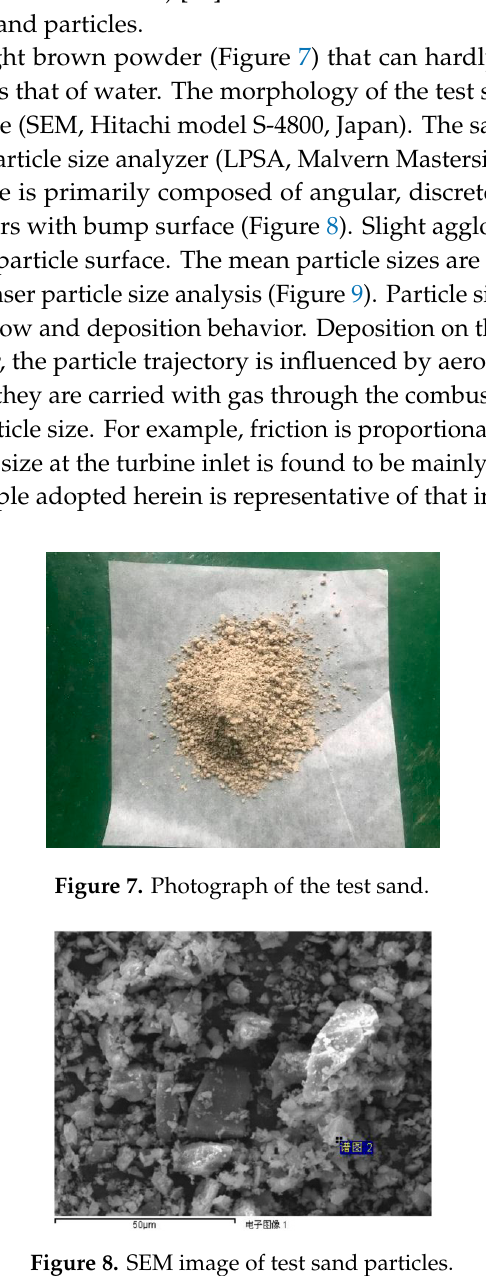
Figure 9. Particle size distribution. The elemental composition was provided using a ThermoFisher Scientific X-ray photoelectron spectrometer (XPS, ESCALAB 250Xi, USA). The XPS survey spectra confirms the existence of oxygen (O), silicon (Si), aluminium (Al), iron (Fe), potassium (K), solium (Na), calcium (Ca), magnesium (Mg) and titanium (Ti) in the test sand. Apart from oxygen, Si was the most abundant element, indicating that silicon dioxide was the major phase in the sand, amounting to more than 70% of the test sand (Figure 10). The rest of the constituents were metal oxides. Figure 10. Chemical composition of the test sand. 2.3. Experimental Parameters The main operating parameters of the deposition test facility are listed in Table 1. The outlet temperatures of modern gas turbine combustors vary from 1200 to 2100 K depending on the engine